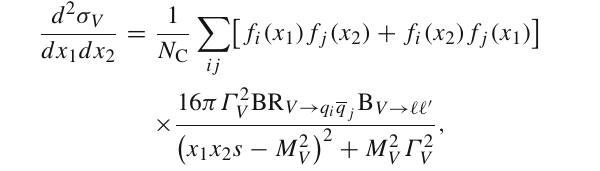
grams are also expected to be the most sensitive to the PDF- dependent shift under study. Indeed, they are the only 2 →